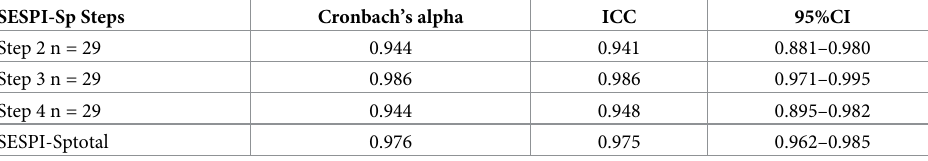
Table 2. Internal consistency and ICC for the last three steps and total of the